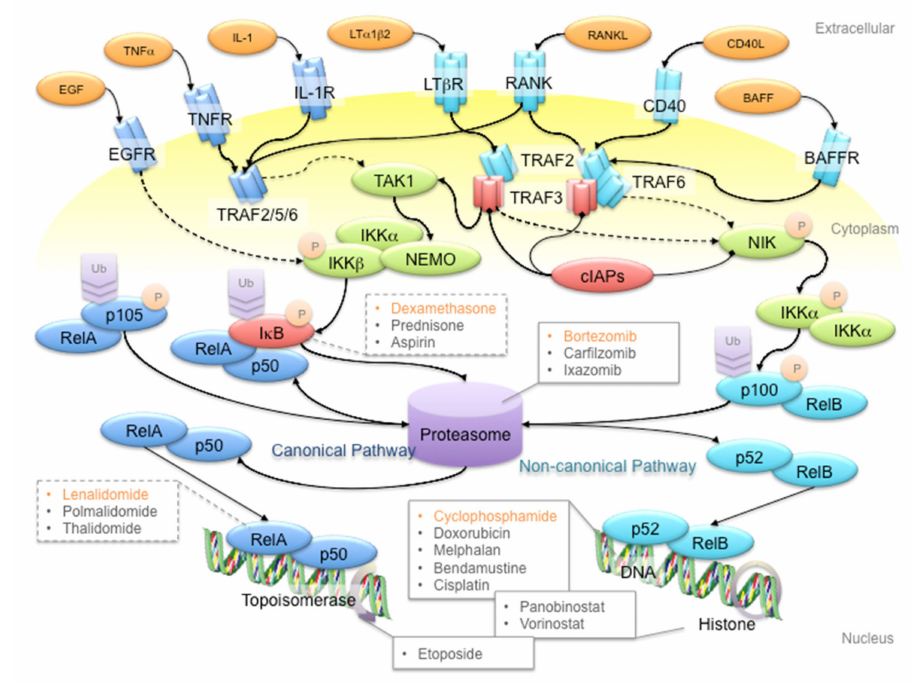
Figure 1. Schematic diagram of the NF- κ B signaling pathway and anti-multiple myeloma (MM) drug targets. First-line anti-MM drugs (highlighted in orange) passively target the canonical and / or non-canonical pathways to shut down NF- κ B signaling. For example, bortezomib inhibits the 26S proteasome to hinder the processing of p105 and p100 proteins, to prevent gene transcription activation in canonical and non-canonical NF- κ B signaling pathways, respectively; dexamethasone induces I κ B protein synthesis to inhibit p105 processing; lenalidomide reduces RelA binding to open chromatin; cyclophosphamide is a DNA alkylating agent that disrupts DNA replication and genome stability. Ligands, adaptor proteins and transcriptional complexes involved in canonical NF- κ B signaling are depicted in dark blue, whereas those involved in non-canonical NF- κ B signaling are depicted in light blue; kinases are depicted in green; inhibitors are depicted in red. P and Ub indicate the post-translational modifications of phosphorylation and ubiquitination, respectively. Arrows with triangle heads indicate activation, whereas arrows with rhomboid heads indicate inactivation / inhibition; direct interactions are indicated by solid lines, whereas indirect interactions are indicated by dash